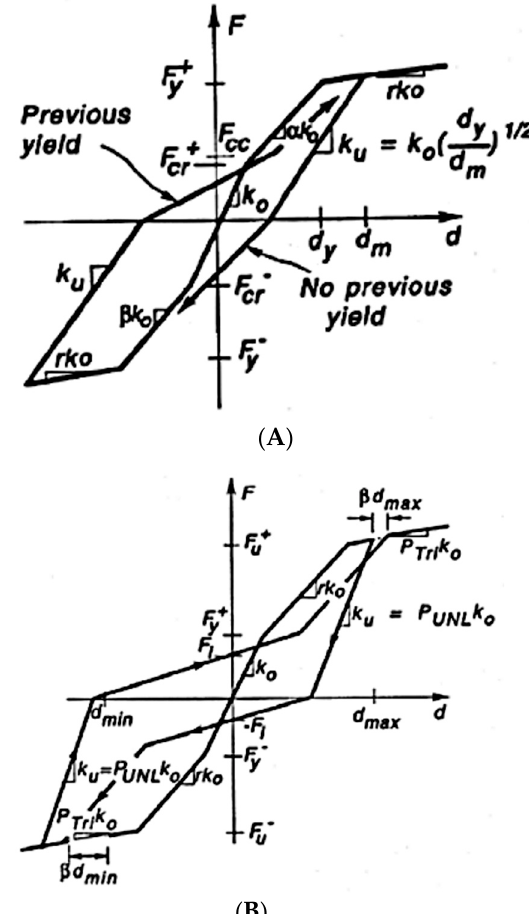
Figure 8. Column and wall model. ( A ) SINA Model [13]; ( B ) Wayne–Stewart Model [14].